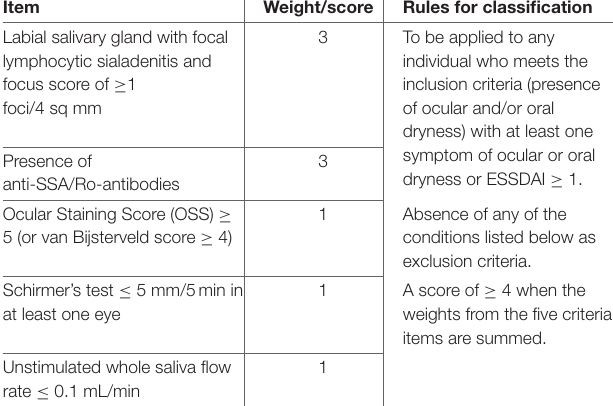
TABLE 1 | The 2016 ACR/EULAR classification criteria for pSS.